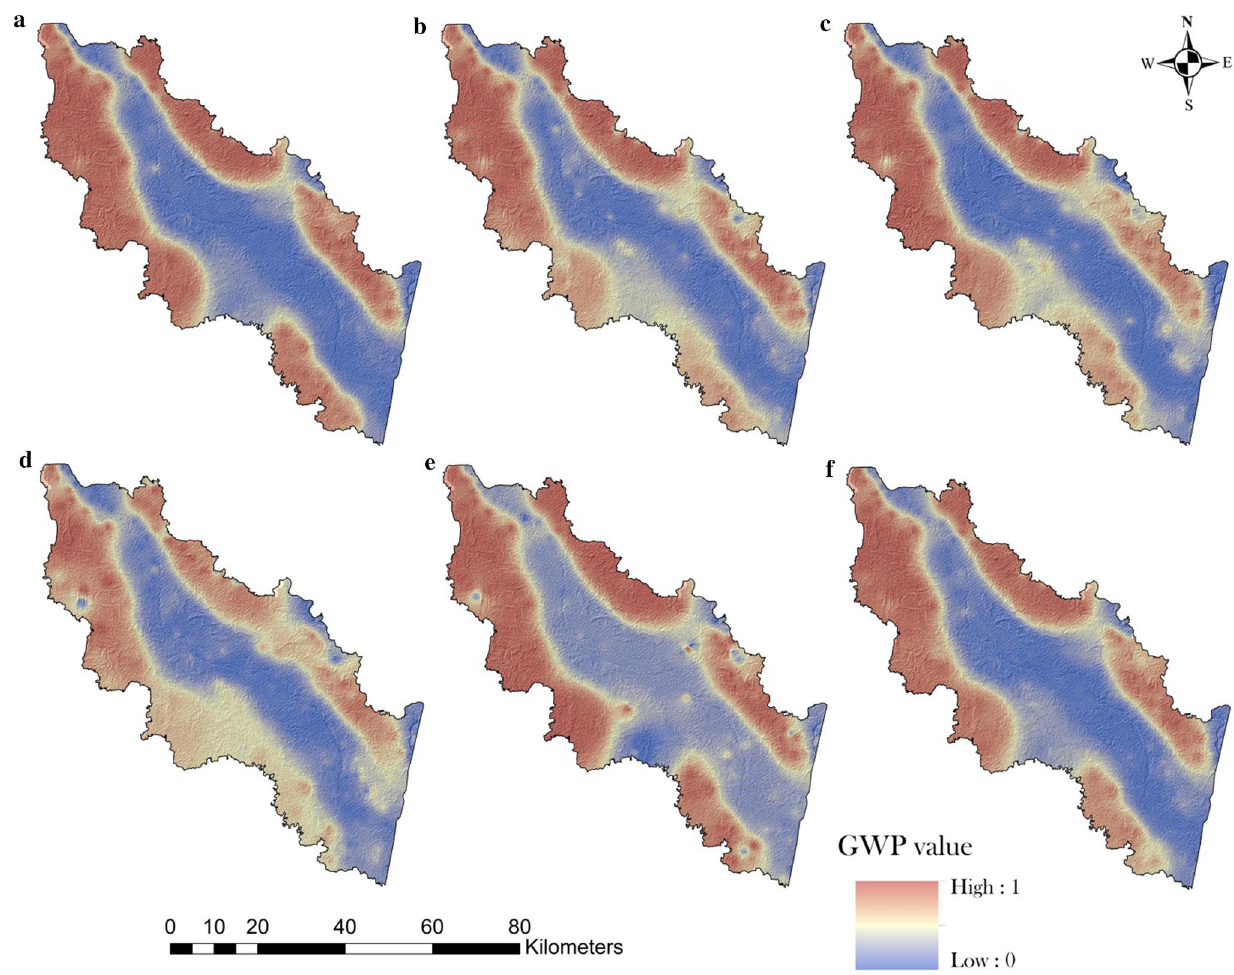
Fig. 8 Conversion of EML models into crisp fuzzy layers, such as a RF, b RS, c bagging, d dagging, e NBT, and f stacking based on linear membership